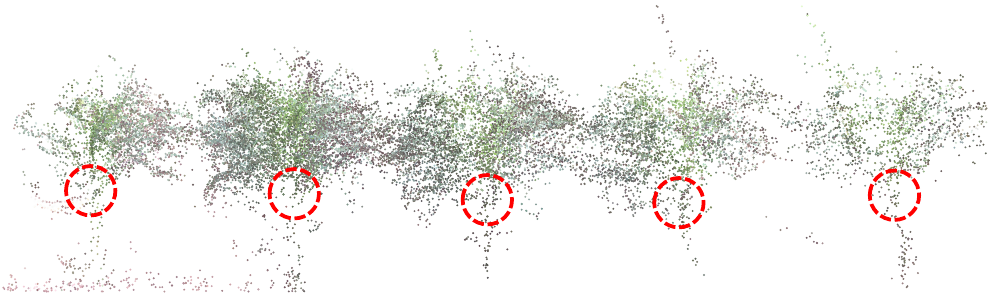
Figure 18. Configuration of selected points as collar of top most leaf on 3D model created by Vinoculer images.